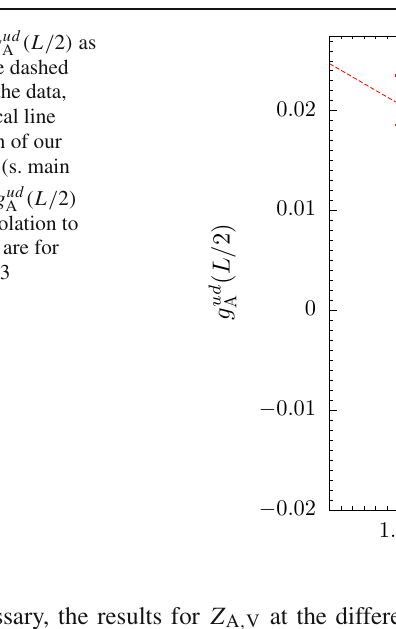
( L / 2 ) as A (s. main f ( L / 2 ) A